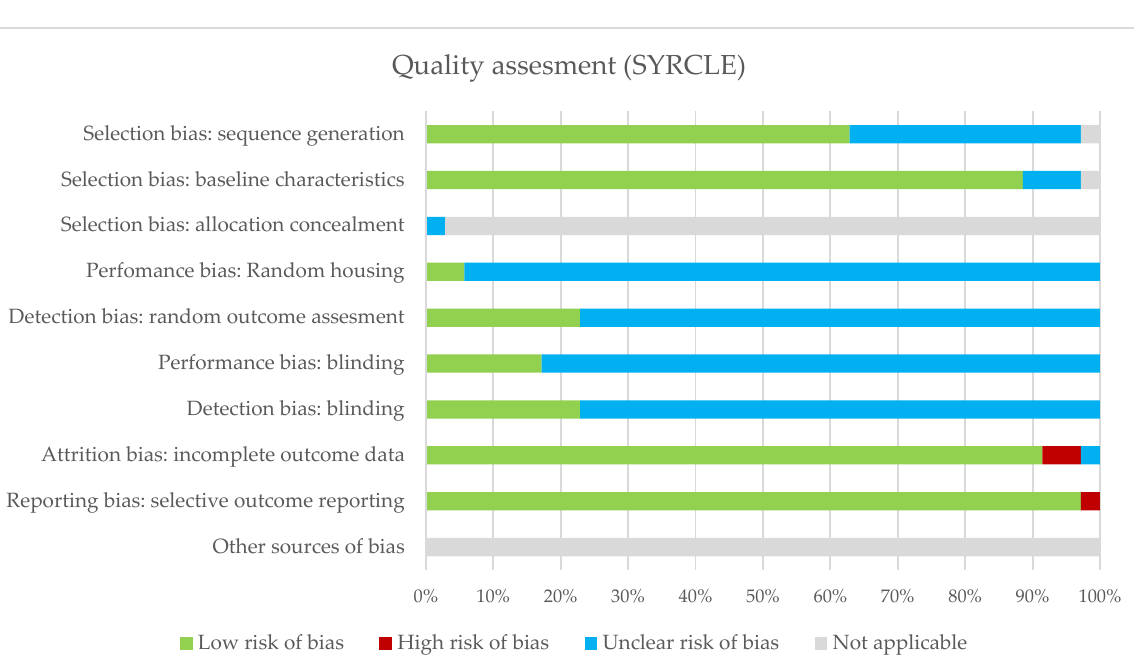
Figure 2. Quality assessment of human studies using the ROBINS-I tool. Abbreviations: BMI body mass index.